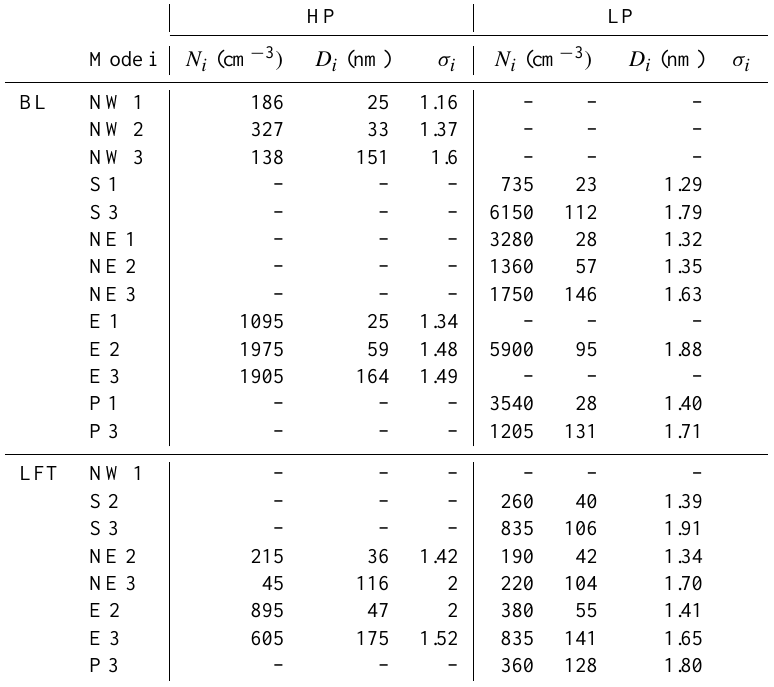
Table 3. Log-normal characteristics of the number size distributions shown in Fig. 4 for the different air mass sectors (NW: north-west Europe; S: south Europe; NE: north Europe; E: east Europe; P: polar). N i represents the concentration, D i is the geometric mean diameter and σ i is the standard deviation of the particle mode i (mode 1 = nucleation; mode 2 = Aitken; mode 3 = accumulation).